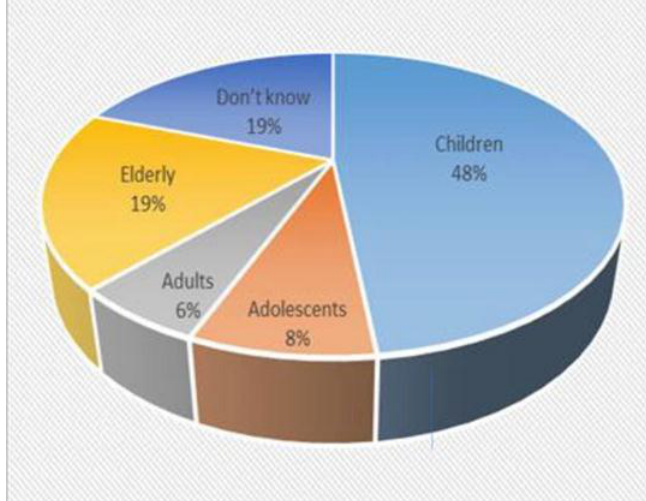
Figure 1 . Distribution of age groups according to their sensitivity to